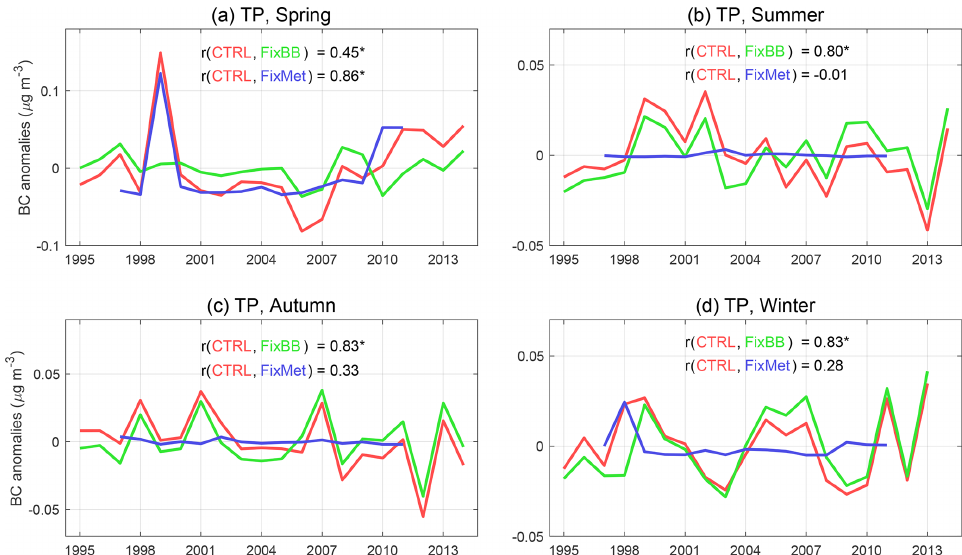
Figure 7. Inter-annual variations in the anomalies of surface BC concentrations averaged over the TP from different simulations during 1995–2014 in the four seasons. Red, green, and blue lines indicate CTRL, FixBB, and FixMet simulations, respectively. Values from the FixBB simulation are shown from 1997 to 2011, corresponding to the covering period of the GFED3 inventory. The anomalies are the BC concentrations in a given year minus those in the 20-year mean. A correlation coefficient ( r ) with “*” indicates that the r is statistically significant ( p < 0.05). Note that the anthropogenic emissions in 2000 were used in the simulations (see Sect. 2.1).